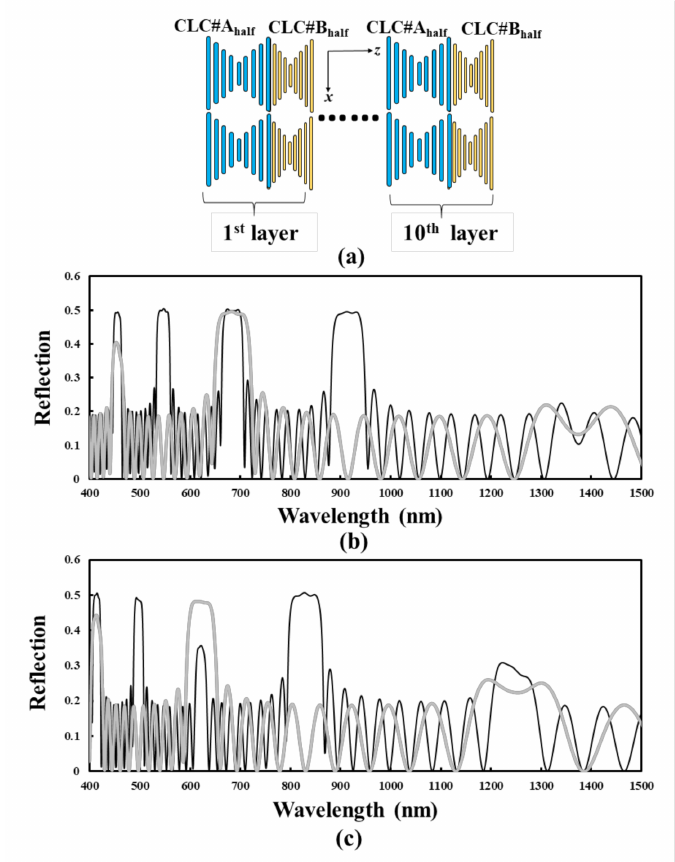
Figure 8. ( a ) The BLCPFs comprise of alternative layers of CLC#A half and CLC#B half ; the thickness of a single layer of CLC#A half [CLC#B half ] equals half of the single pitch length of CLC#A [CLC#B], as shown in Figure 1. The black curves are identical to the curves shown in Figure 2c with the pitch lengths of CLC#B of ( b ) 310 nm and ( c ) 230 nm. The gray curve is the simulation reflection spectrum of BLCPFs when the thickness of a single layer of CLC#A half equals 280 nm, which equals half of the single CLC#A pitch length of 560 nm in Figure 2; the thicknesses of a single layer of CLC#B half equal to ( b ) 155 nm and ( c ) 115 nm, which equal half of the single CLC#B pitch lengths of 310 and 230 nm in Figure 2c,